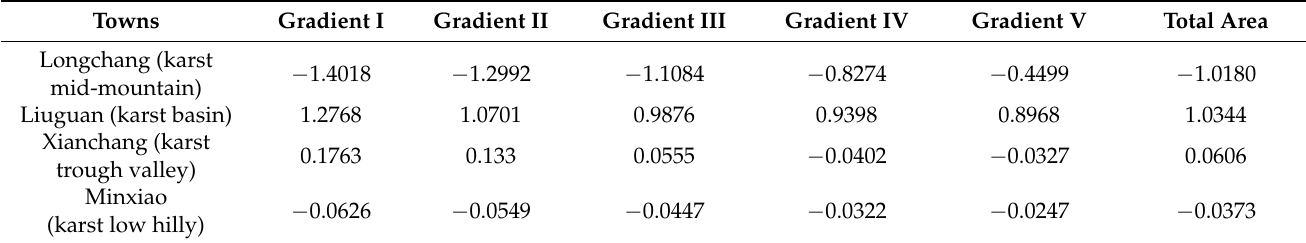
Table 6. The changes of landscape ecological risk from 2010 to 2020.